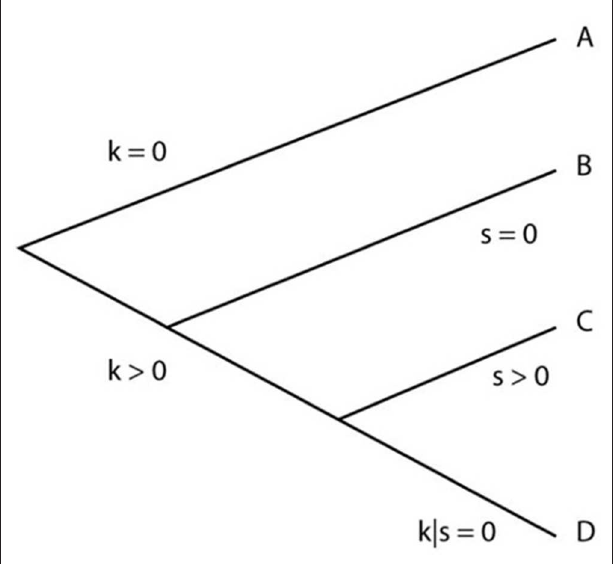
FIGURE 1 | Williamson’s contracting processes. Source: Berg et al. (2019). FIGURE 2 | Opportunism and contracts. Source: Berg et al.